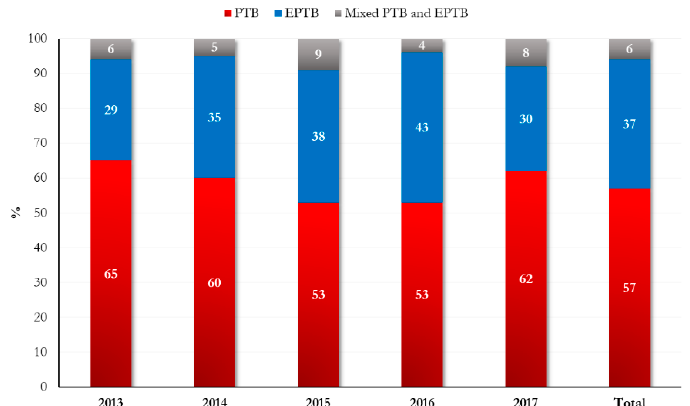
Figure 1. Temporal distribution of tuberculosis-related admissions from 2013 to 2017 in the study cohort.